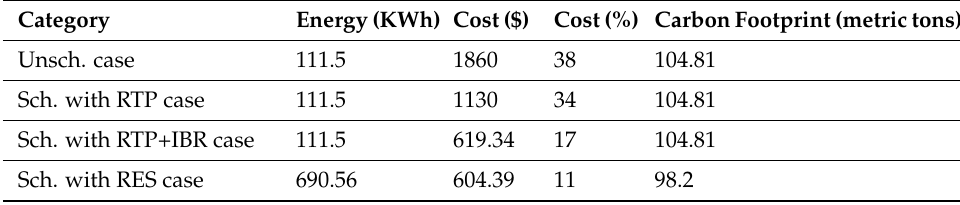
Table 7. Overview of all simulation